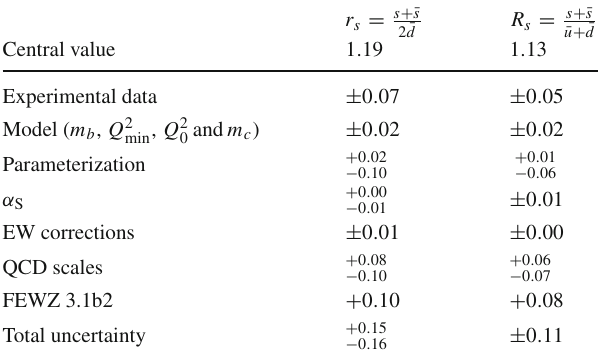
Table 20 Summary of the central value and all uncertainties in the variables r s and R s evaluated at Q 2 = 1 . 9 GeV 2 and x = 0 . 023 char- acterizing the fraction of the strange-quark density in the proton r s = s +¯ s 2 ¯